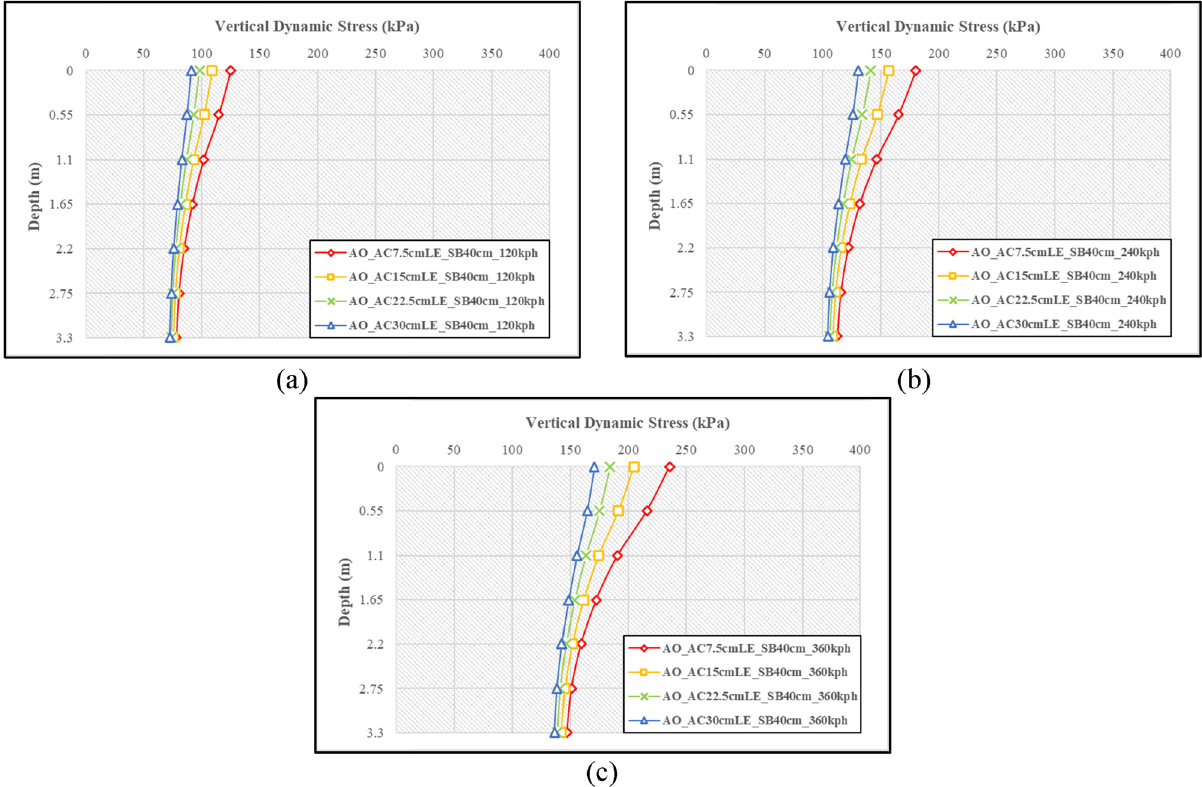
Figure 11: Vertical compressive stress curve in subgrade layer of asphaltic overlayment track with 7.5, 15, 22.5, and 30 cm of AC layer: ( a ) 120 kph, ( b ) 240 kph, and ( c ) 360